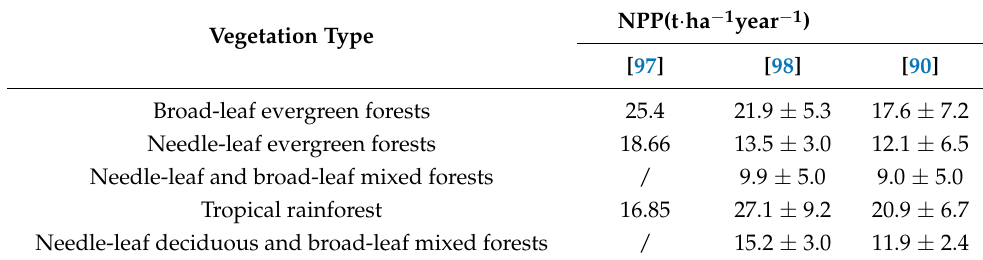
Table 7. Summary of the annual average NPP of common forest vegetation in Southwest